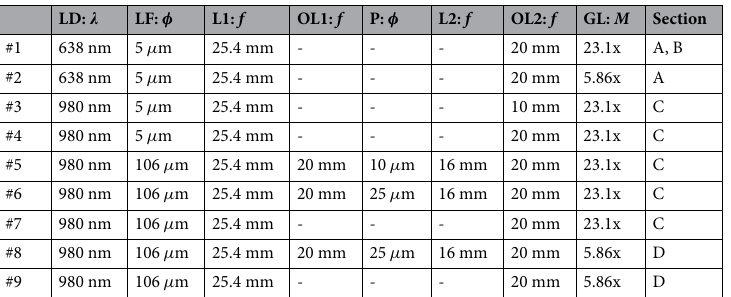
(Fig. 2c). By eliminating the steering mechanism from the distal side in the prototype system, the size of the distal end can be as small as that of the GRIN lens, fiber bundle or holder (Fig. 2d). Laser steering under endoscopic observation. To assess the simultaneous performance of imaging and laser steering by the endoscopic laser treatment system, a target pattern printed on white paper was placed on the distal irradiated plane. A red laser was used for visualizing the laser irradiation position with setup # 1. The laser input position into the core was controlled by the galvo mirror system, and the irradiation position on the distal irradiated plane was observed. To demonstrate the laser steering in a narrow space, the distal end of the system was inserted into a vascular model with an atherosclerotic plaque (diameter, 8 mm; HXBVX01P08009JX, WetLab) with setup # 2. The inside of the model was illuminated with a light-emitting diode (SOLIS-3C, Thor- labs) from the outside. The model of the plaque was colored with black ink to make it easier to distinguish from the vascular wall model and to observe the movement of the laser spot on the target. Laser steering evaluation. The precision and accuracy of laser steering were evaluated using three target patterns: a circle, a wavy circle, and a four-leaved pattern. The target patterns were printed within a circle with a diameter of 4.3 mm. A beam profiler (sensor size, 6.7 µ m; frame rate, 16 fps; LaserCam-HR, Coherent) was placed at the distal irradiated plane to continuously record the light intensity profile during laser steering. The laser steering was conducted five times along each target pattern by automatic modulation of the galvo mirror system with setup # 1. The steering speed was 0.17 mm/s on the distal irradiated plane. The laser irradiation position was defined as the center of gravity of the light intensity profile. The accuracy, which represents the performance of the laser irradiation position control with respect to the target, was evaluated as the mean of the root-mean-square error (RMSE) between the target position and the irradiation position. The precision, which represents the reproducibility of the laser irradiation position control, was evaluated using the standard devia- tion of the RMSE.